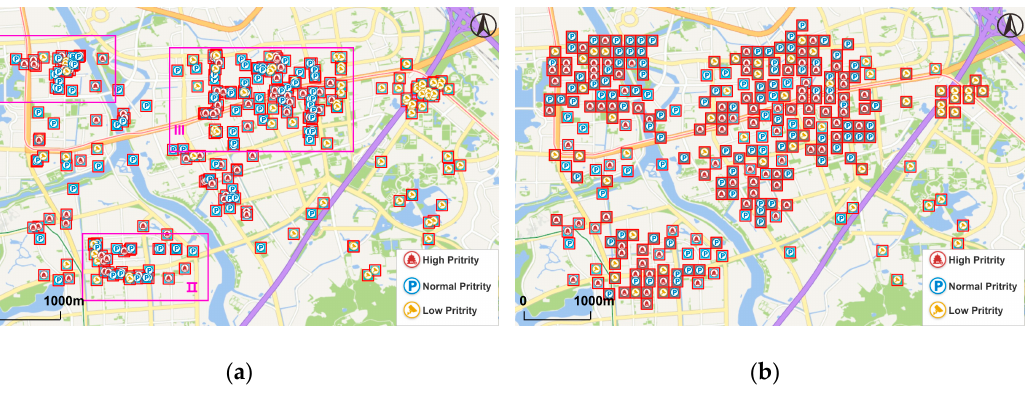
Figure 10. Original points and generalization results at LOD 14. (a) original points at LOD 14; (b) generalization results at LOD 14.